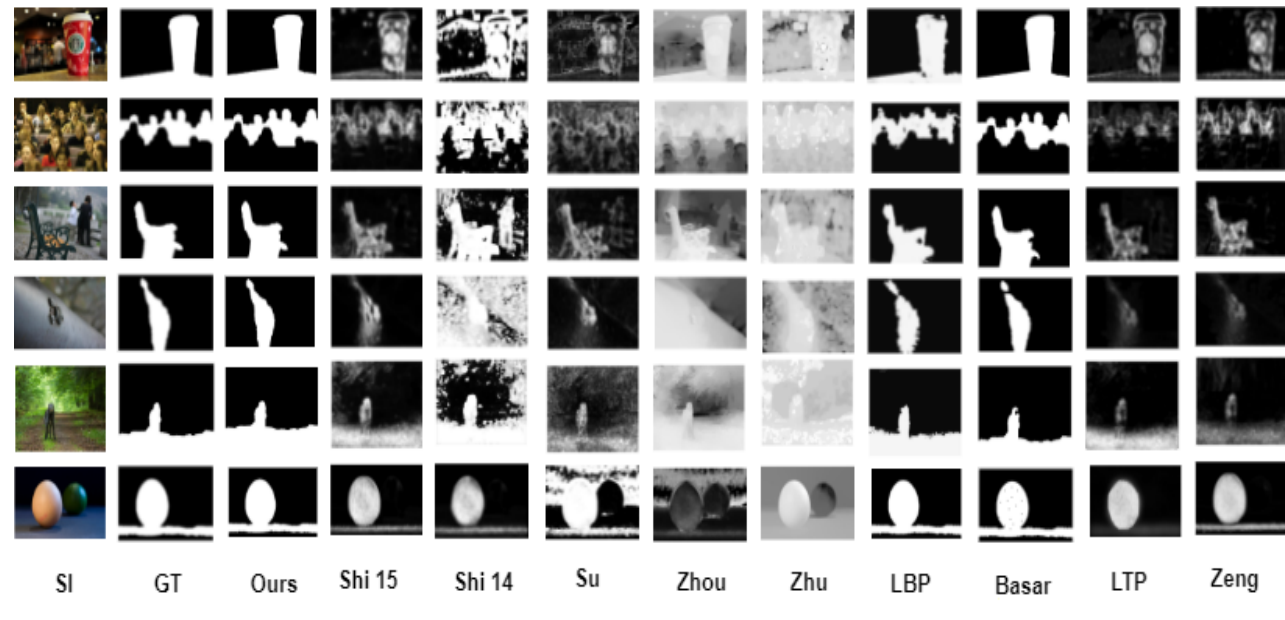
Figure 7. Defocus blur segmentation result presented by various defocus algorithms stated as Shi15 [14], Shi14 [16], Su [17], Zhou [18], Zhu [19], LBP [20], Basar21 [21], LTP [22], Zeng